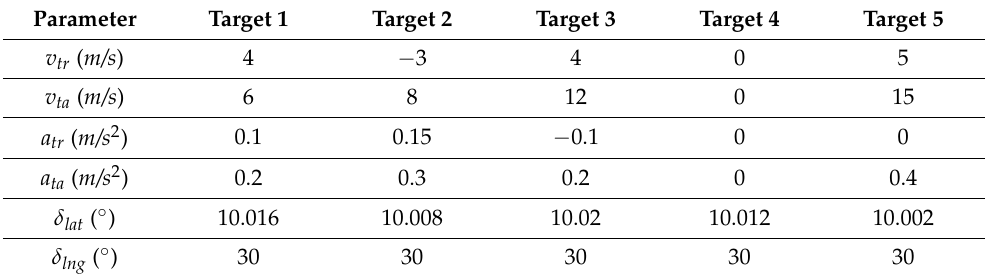
Table 2. Parameters of the